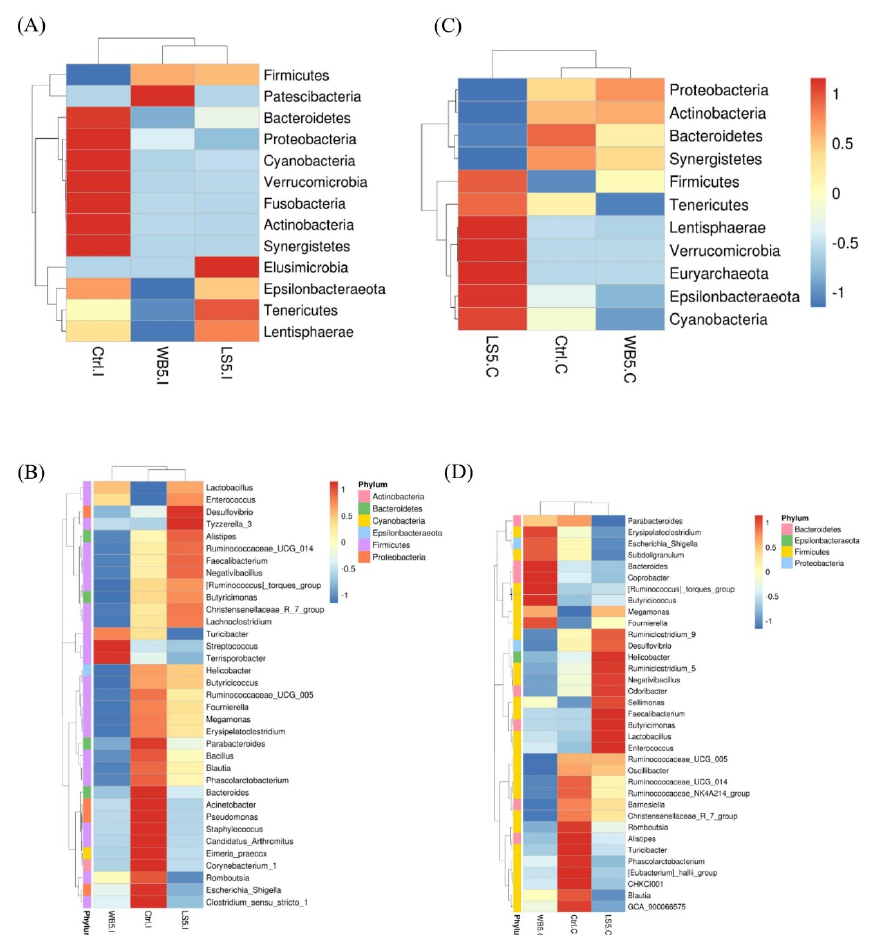
Figure 2. Heat maps showing the microbiota composition at the phylum and genus level in the ileum ( A , B ) and cecum ( C , D ) of 35-day-old broilers supplemented with WB and LS. Ctrl: control group, WB5: broilers supplemented with 5% wheat bran, LS5: broilers supplemented with 5% Laetiporus sulphureus wheat bran. Results are means of six samples obtained from the individual birds of each of the control and experimental